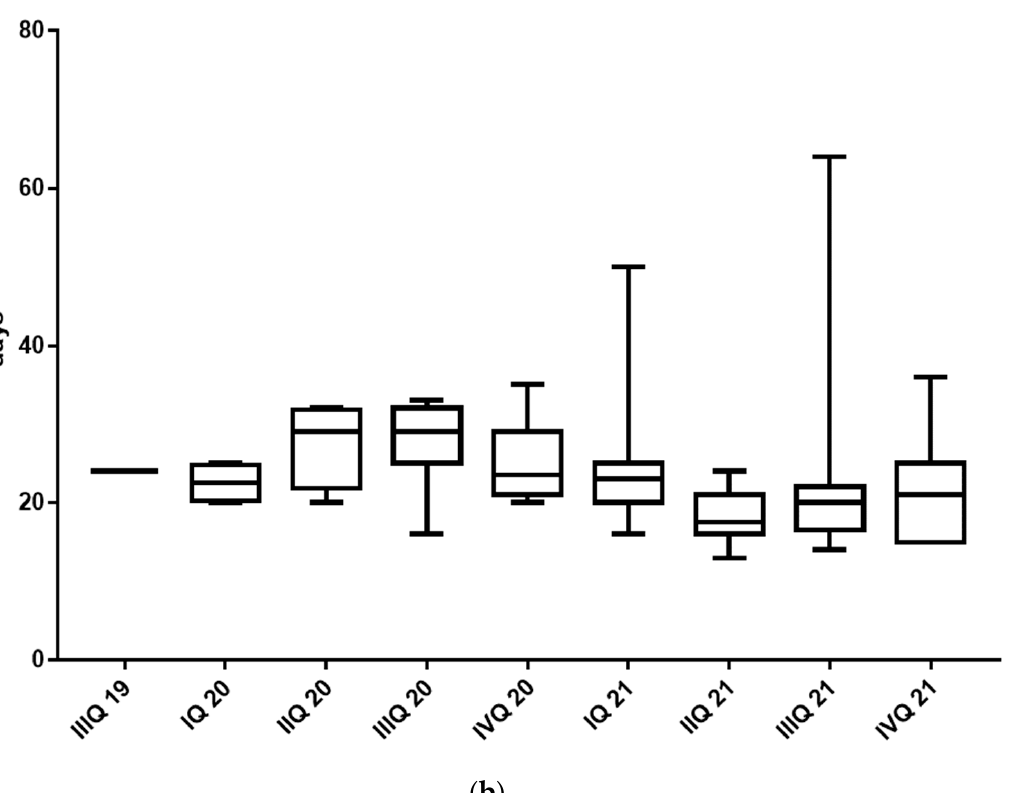
Figure 2. ( a ) Time between ordering and reporting the results of the HRD test in different time intervals during the implementation phase. ( b ) Time between ordering and reporting the results of the established germline test in different time intervals during the HRD test implementation phase.